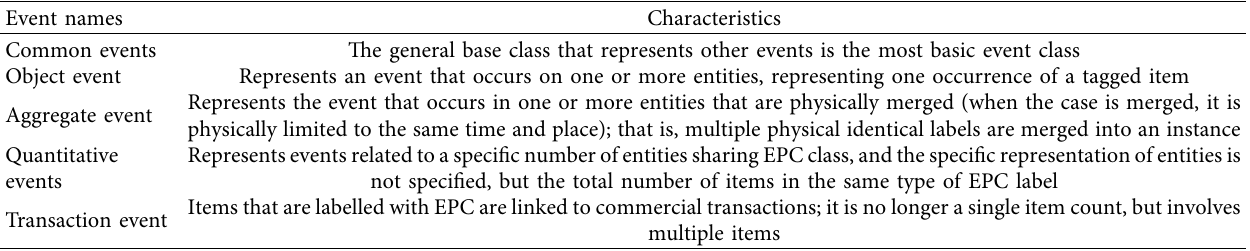
Table 1: Types and characteristics of complex